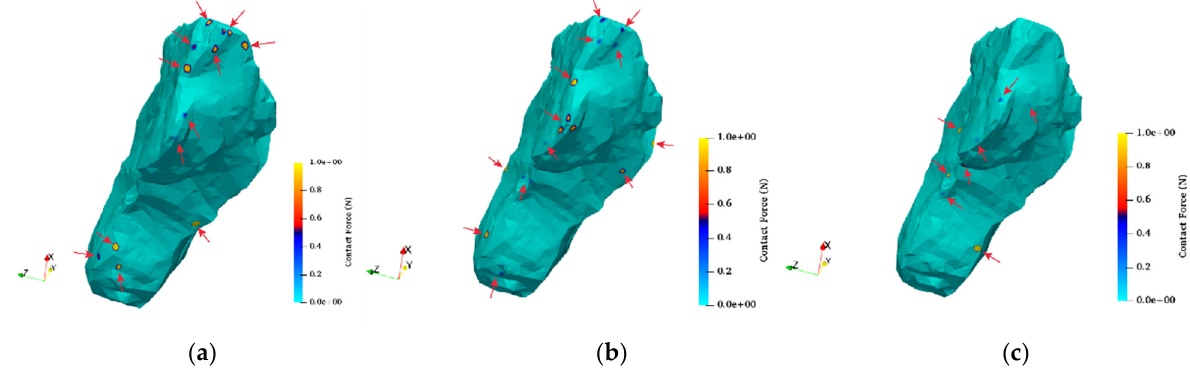
Figure 12. Contact positions on the debris. ( a ) 13.7 s, ( b ) 17 s, and ( c ) 20 s.